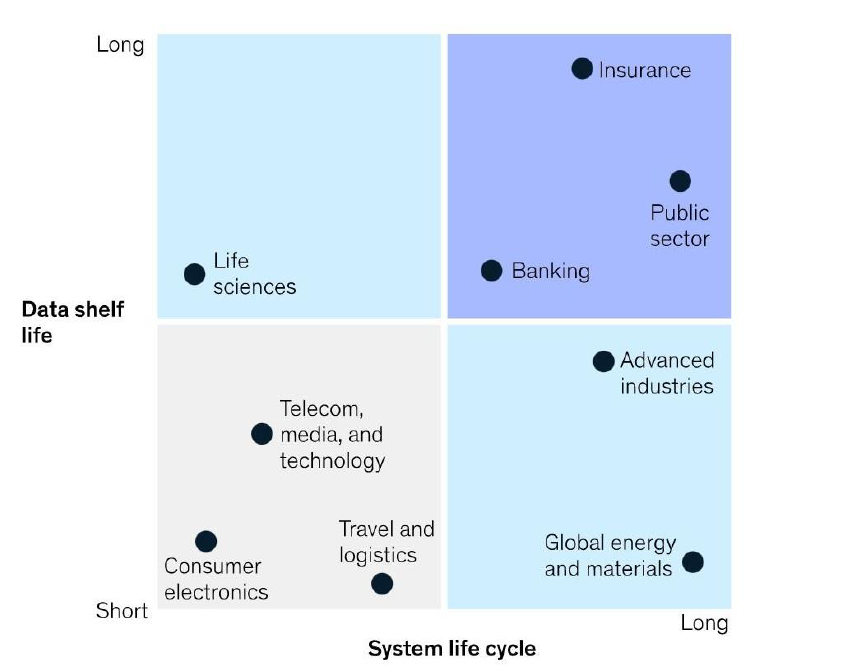
Figure 2. Risk of quantum-powered attack by industry. Source: McKinsey Digital [17].